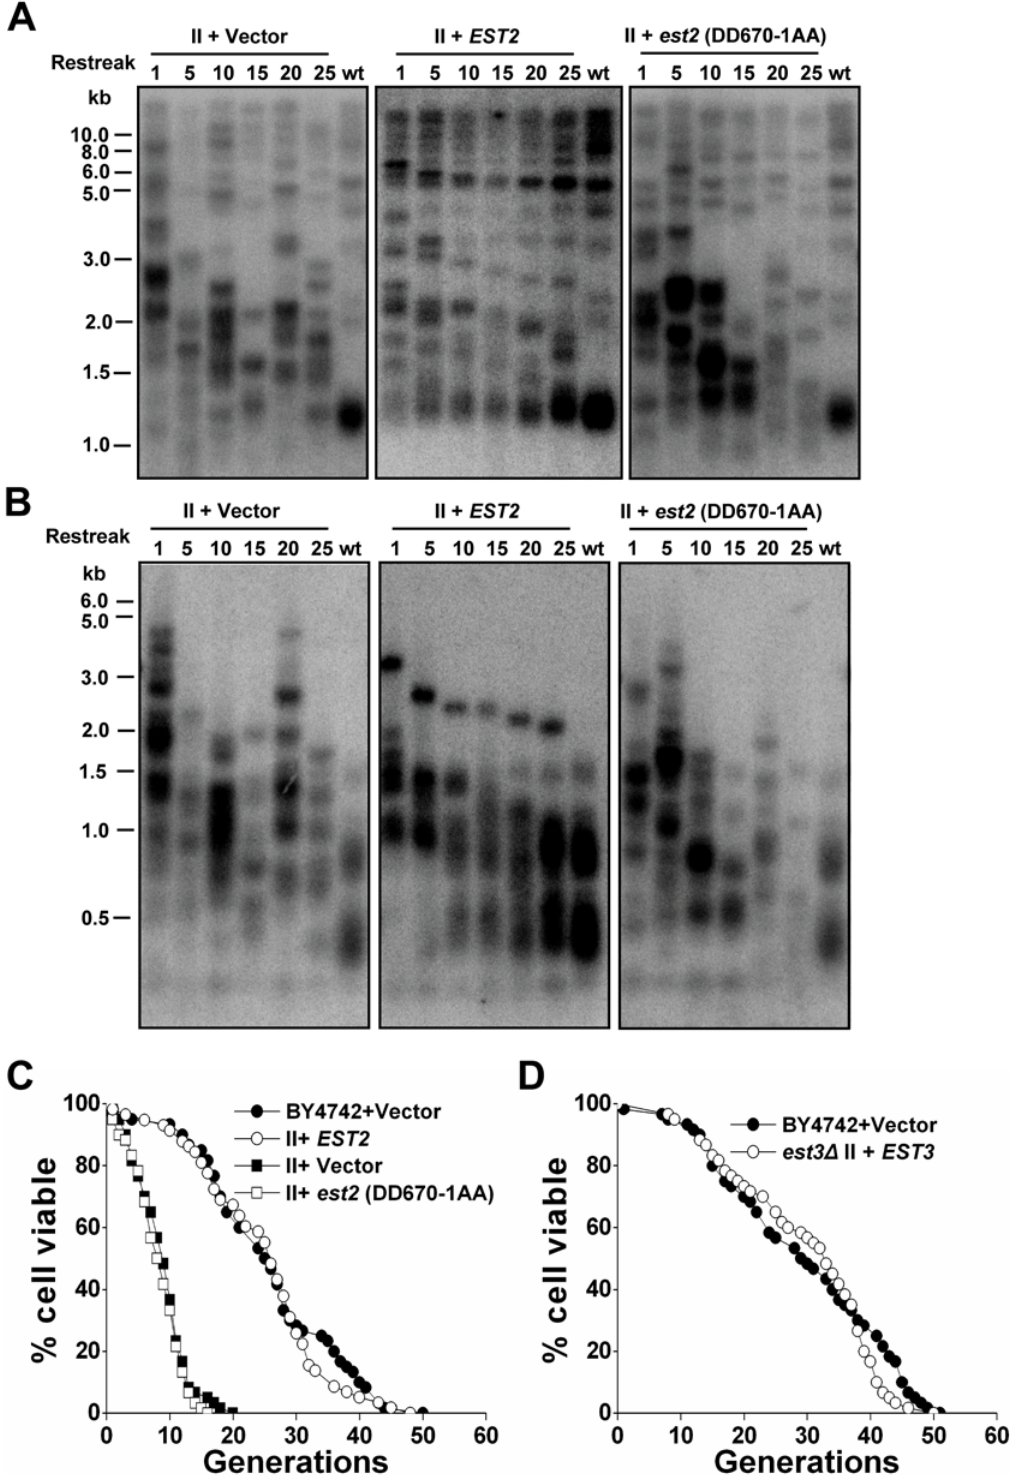
Figure 6. Reintroduction of telomerase activity restores telomere pattern and life span of the type II survivors. Southern blot analysis showing the dynamic changes of telomeric DNA in type II survivors after being transformed with EST2 (wild-type), catalytically inactive est2 (DD670- 1AA), or the vector control plasmid. Cells were serially restreaked and genomic DNA from cells obtained after each indicated restreaks (labeled on top of each panel) was digested with restriction enzyme and probed with a telomere probe. (A) Genomic DNA was digested with Xho I. (B) Genomic DNA was digested with 4 bp cutter ( Msp I, Hae III, Hinf I, Alu I). (C) Life span analysis of the 1 st restreaked cells after plasmid transformation. Mean life span of strains shown: BY4742 + Vector, 23.3 6 9.5 (n=56); est2 D type II + EST2 , 24.6 6 10.1 (n=58); est2 D type II + vector, 12.1 6 4.9 (n=59); est2 D type II + est2 (DD670-1AA), 12.1 6 4.1 (n=60). (D) Life span analysis of strains freshly transformed with EST3 (wild-type) or the vector control plasmid. Mean life span of strains shown: BY4742 + Vector, 29.4 6 12.8 (n=60); est3 D type II + EST 3, 29.8 6 11.1 (n=60).